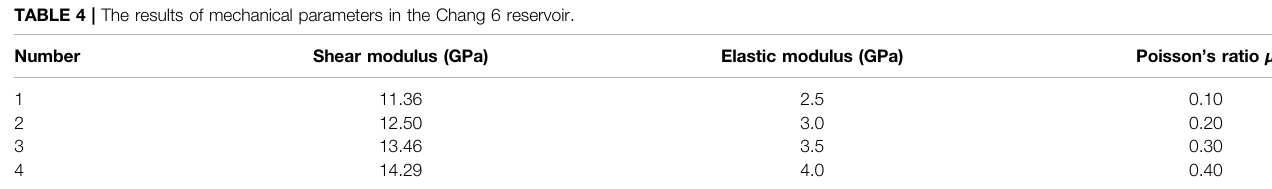
TABLE 4 | The results of mechanical parameters in the Chang 6 reservoir.